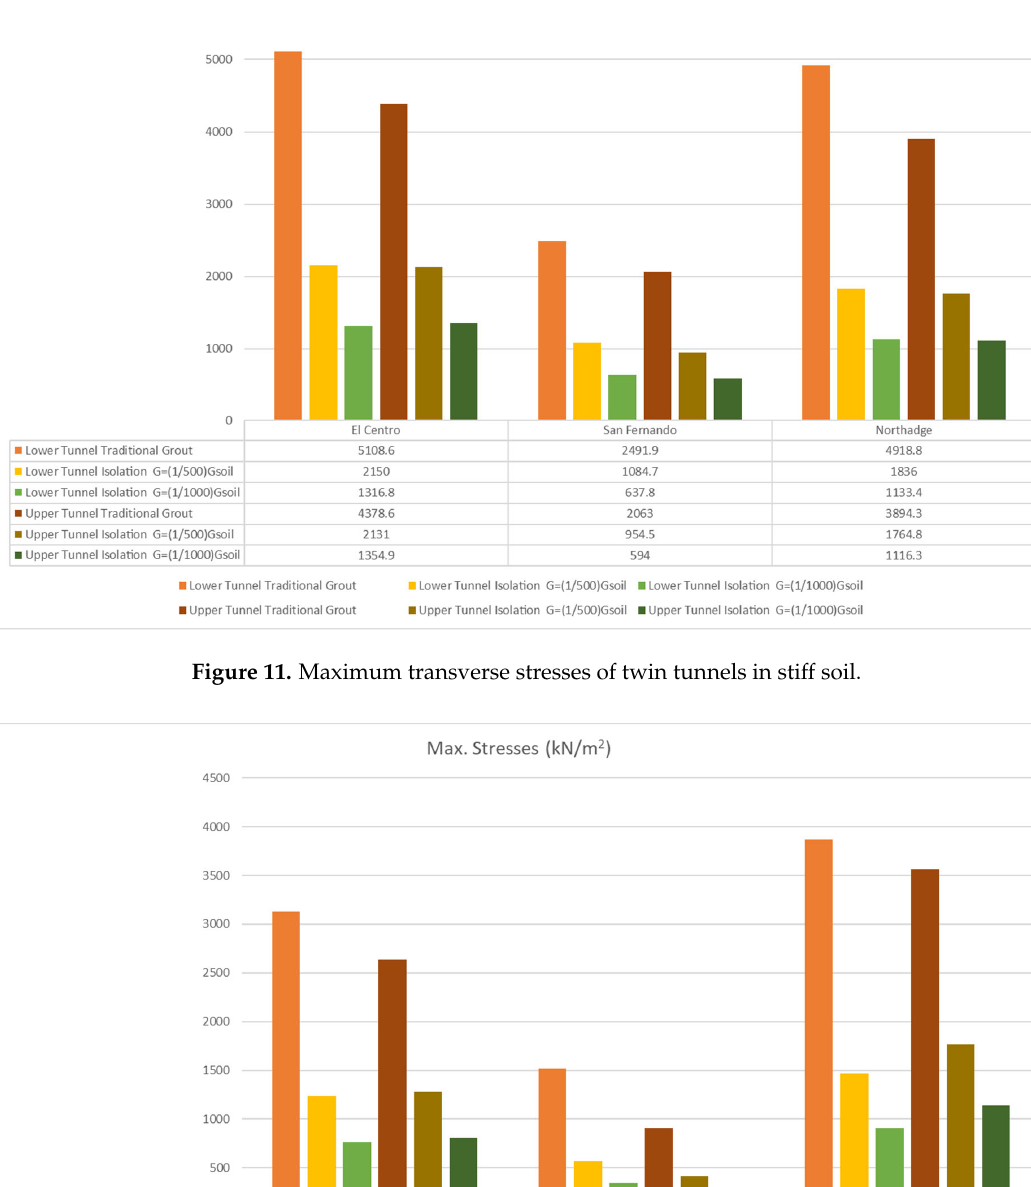
Figure 13. Maximum transverse stresses of the upper tunnel in stiff soil and the lower tunnel in soft soil.